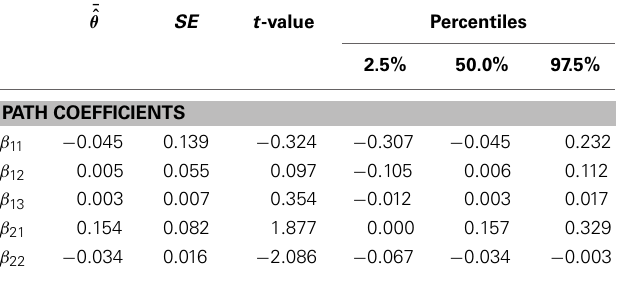
Table 2 | Mean parameter estimates, standard errors, t -values, and 2.5, 50.0, and 97.5% percentiles for the parametric model (cubic relationship for Att and quadratic relationship for Strat) on Level 1.